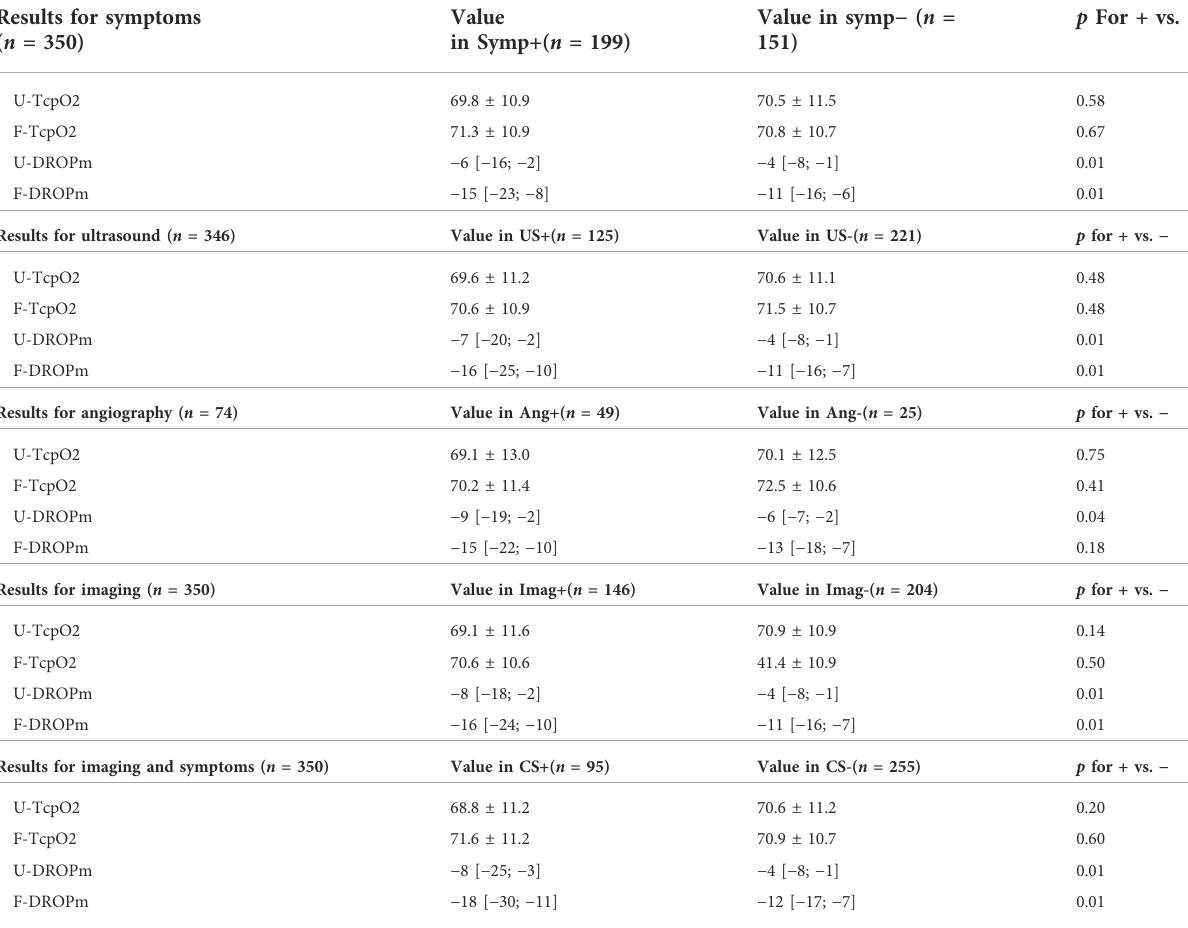
TABLE 2 Values for transcutaneous oximetry at rest (TcpO2) and during the Ca-Pra maneuvre (DROPm) at the forearm and upper arm levels, for detecting the presence of symptoms (Symp+), a compression during ultrasound (US+), during angiography (Ang+), or during imaging (Img+): either a positive ultrasound or a positive angiography, or symptoms with positive imaging (CS+). Note that for ultrasounds and angiography, the numbers of observations are only 346 and 74 respectively. Numbers in parentheses are the number of upper limbs in each group. p for + vs. – is comparison of values in patients with positive or negative results to the reference